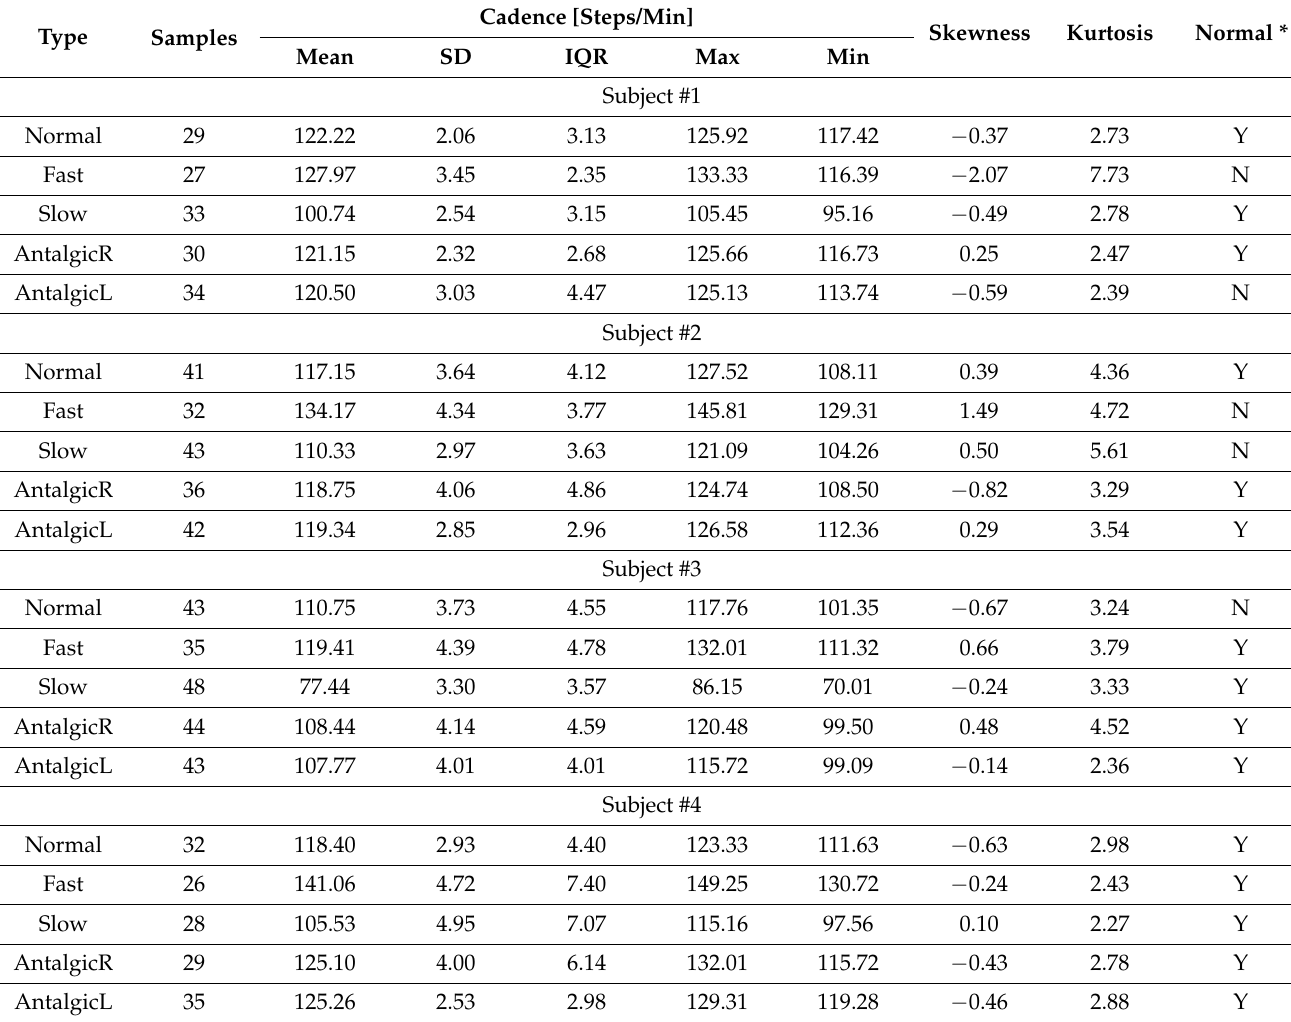
Table 10. Descriptive Statistics and Normality of Cadence Data.